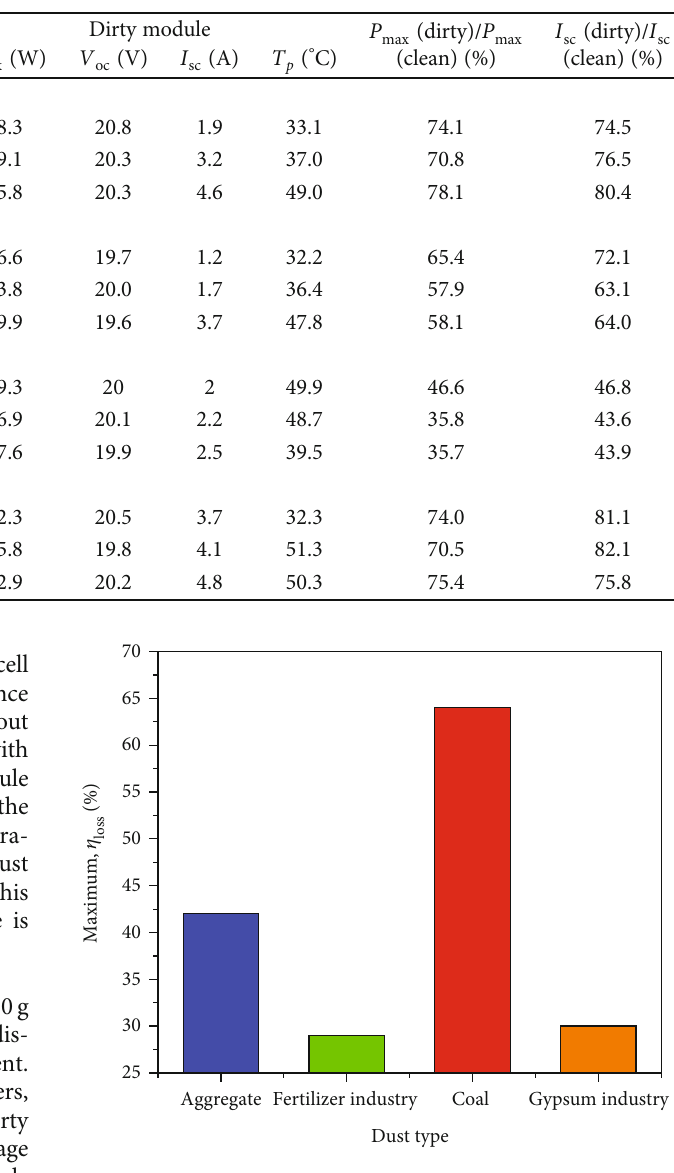
fi ne particles.